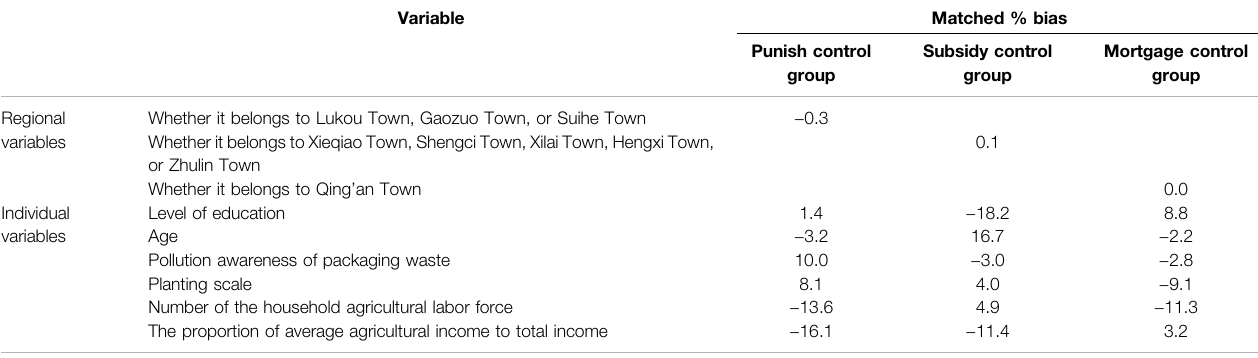
TABLE 7 | Matching balance test.